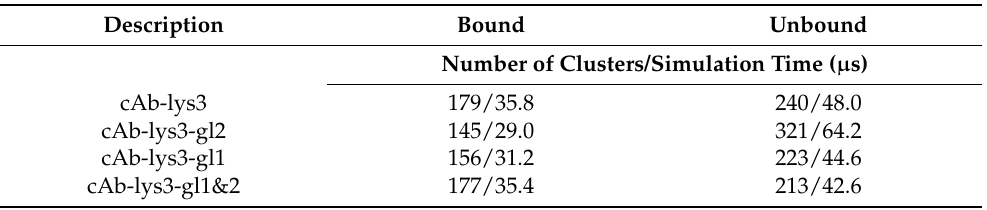
Table 1. Number of clusters obtained by clustering the metadynamics trajectories on the CDR loops 1, 2 and 3 and the resulting aggregated simulation